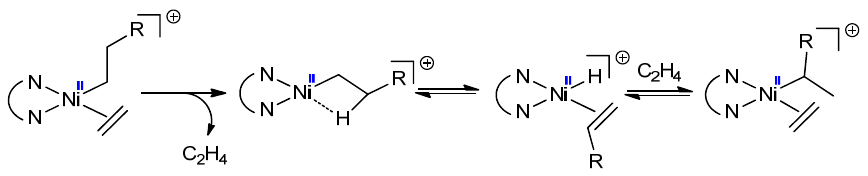
Scheme 2. Chain-walking mechanism of Me-branch formation in the course of Ni(II) α -diimine cat- alyzed ethylene polymerization [33]. alyzed ethylene polymerization [33].